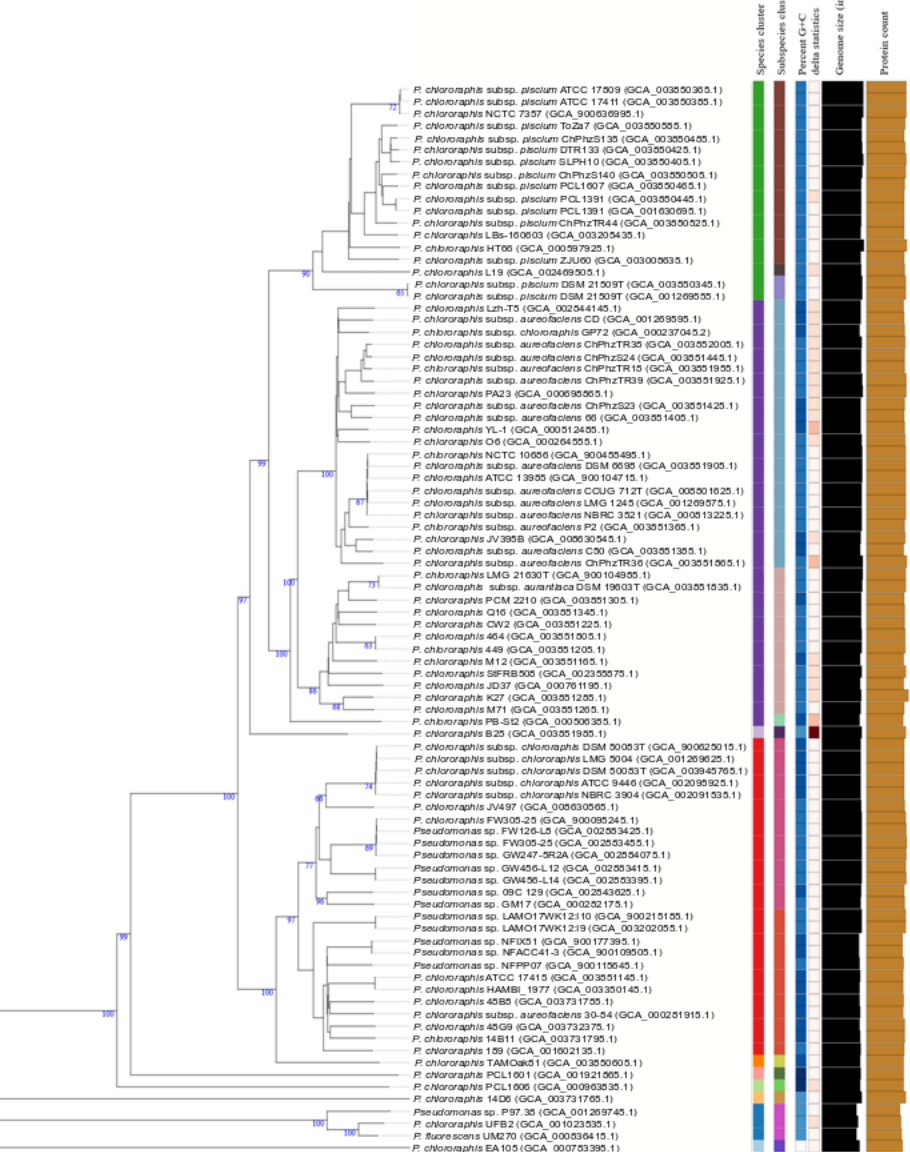
Figure 4. P. chlororaphis species and subspecies delineation based on the GBDP phylogenetic analyses retrieved from the TYGS website. The tree was inferred with FastME 2.1.6.1 [32] from GBDP distances calculated from genome sequences. The branch lengths are scaled in terms of GBDP distance formula d5. The numbers above branches are GBDP pseudo-bootstrap support values >60% from 100 replications, with an average branch support of 83.0%. The tree was rooted at the midpoint [33].